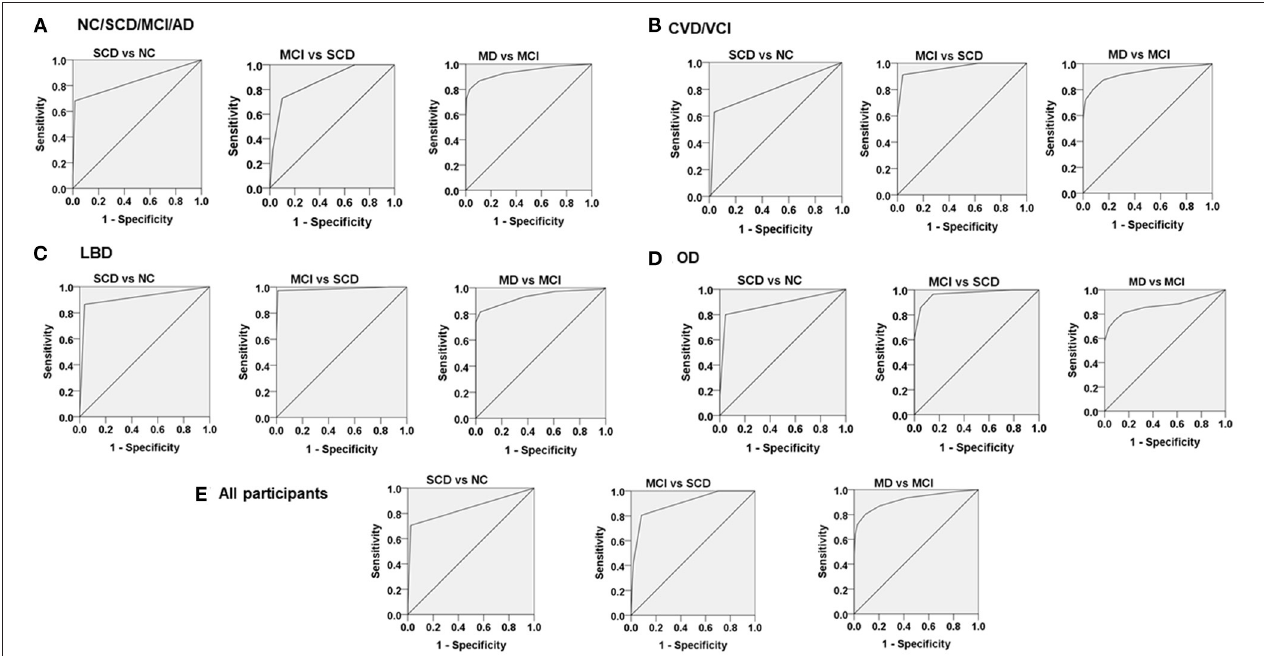
FIGURE 1 | The receiver operating characteristic (ROC) analysis to determine the cutoff scores of the sum of boxes of the Clinical Dementia Rating Scale for normal cognition/subjective cognitive decline (SCD), SCD/mild cognitive impairment (MCI), and MCI/mild dementia among (A) the AD group, (B) the CVD/VCI group, (C) the LBD group, (D) the OD group and (E) all participants. TABLE 4 | Spearman’s correlation coefficients between age, education, and different diagnostic tools for cognitive impairment. Age Education CDR-SB MoCA CASI NPI CI stages Age 1.00 Education − 0.49 ** 1.00 CDR-SB 0.43 ** − 0.34 ** 1.00 MoCA 0.62 ** 1.00 0.54 ** − 0.71 ** 0.97 ** 1.00 NPI 0.04 * − 0.08 ** 0.35 ** − 0.15 ** − 0.15 ** 1.00 CI stages 0.38 ** − 0.31 ** 0.83 ** − 0.66 ** − 0.64 ** 0.30 ** 1.00 CDR-SB, sum of boxes of the Clinical Dementia Rating Scale; MoCA, Montreal Cognitive Assessment; CASI, Cognitive Abilities Screening Instrument; NPI, Neuropsychiatric Inventory; CI stages, cognitive impairment stages grouped using the CDR-SB in all participants. * p < 0.01; ** p <